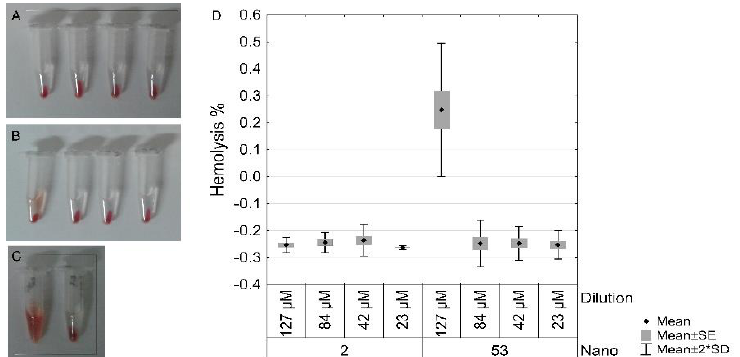
Figure 11. Samples from the groups used in the hemolysis test, after Laser ablated Albumin function- alized AuNPs (LA-AuNPs) incubation with erythrocytes, centrifugation, and removal of supernatant for optical density analysis. Vials with erythrocytes exposed to nanoparticles 2 nm LA-AuNPs ( A ), 53 nm LA-AuNPs ( B ), in the dilutions 1:1 (127 µ M), 1:2 (84 µ M), 1:5 (42 µ M) and 1:10 (23 µ M) from left to right, respectively. Positive control was prepared with distilled water and negative control with saline solution ( C ). Data from the hemolytic activity percentage were analyzed by ANOVA ( D ), represented as mean ± SE (standard error) ± 2 SD (standard deviation).